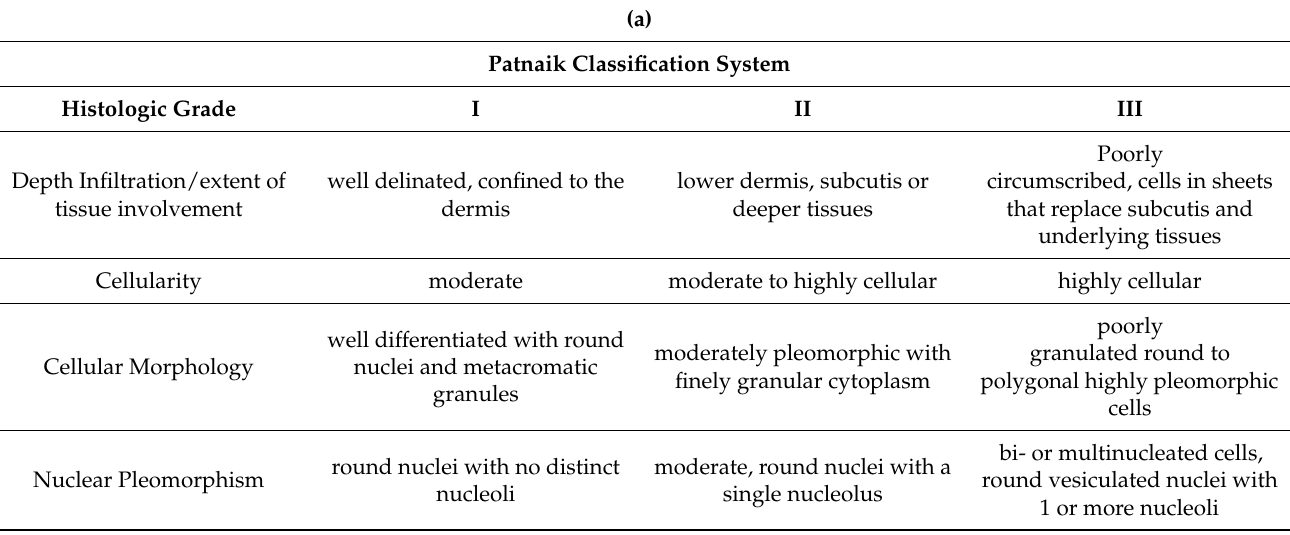
Table 1. ( a ) Histopathologic criteria for Patnaik’s grading scheme. ( b ) Histopathologic criteria for Kiupel’s grading